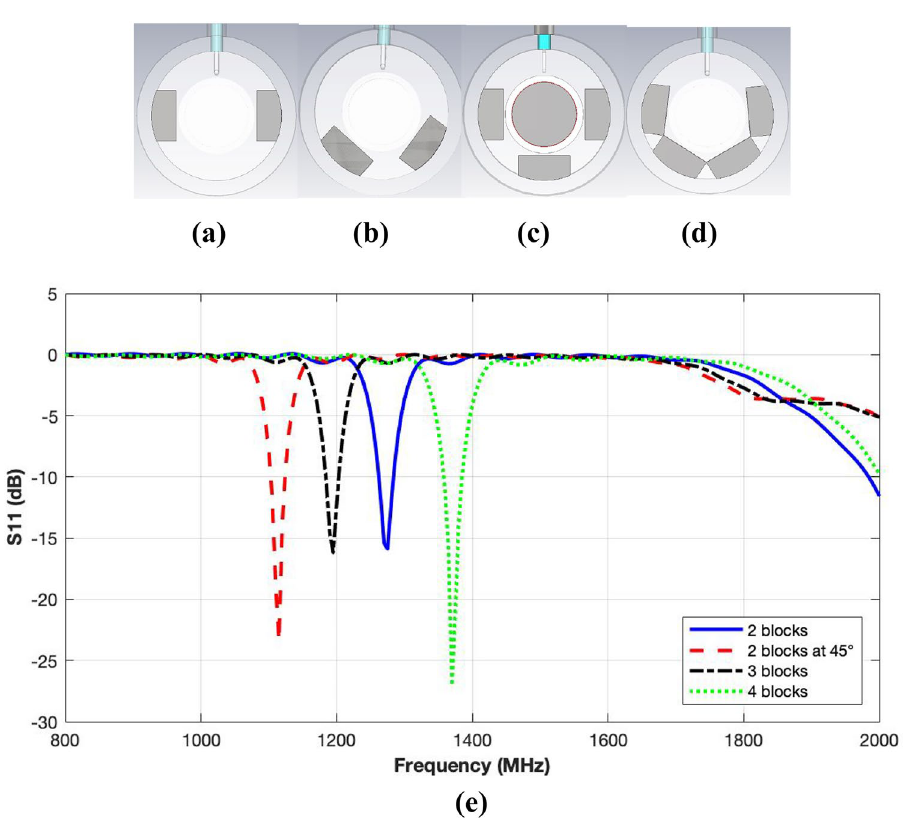
Figure 5. Geometry of loaded cylindrical re-entrant resonant cavity with metallic blocks; ( a ) Two blocks; ( b ) Two blocks at 45°; ( c ) Three blocks; ( d ) Four blocks; ( e ) Reflection coefficient responses for loaded cavity with metallic